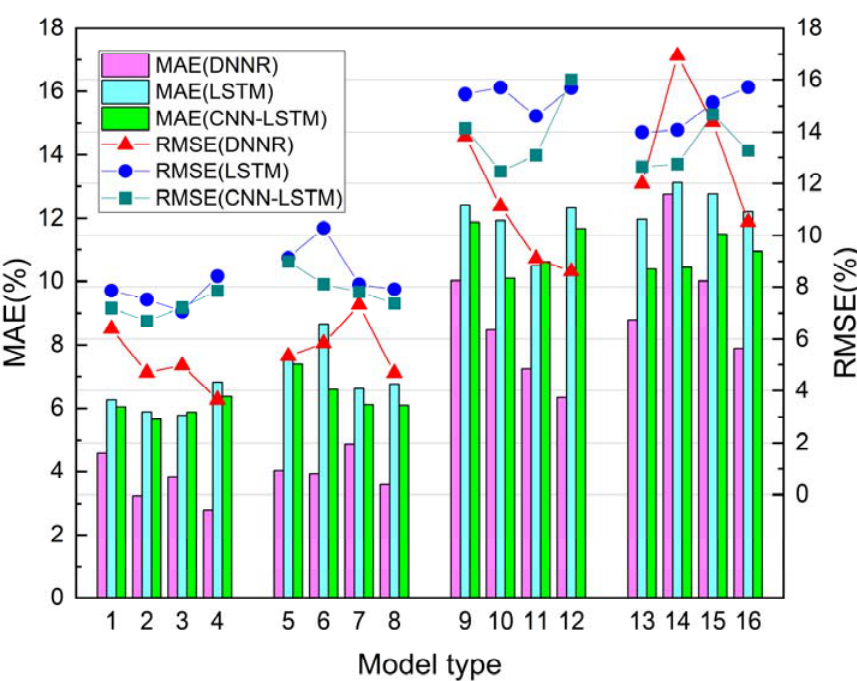
Figure 9. The RMSE and MAE of the best experimental model for Greenhouse A humidity under 16 datasets.